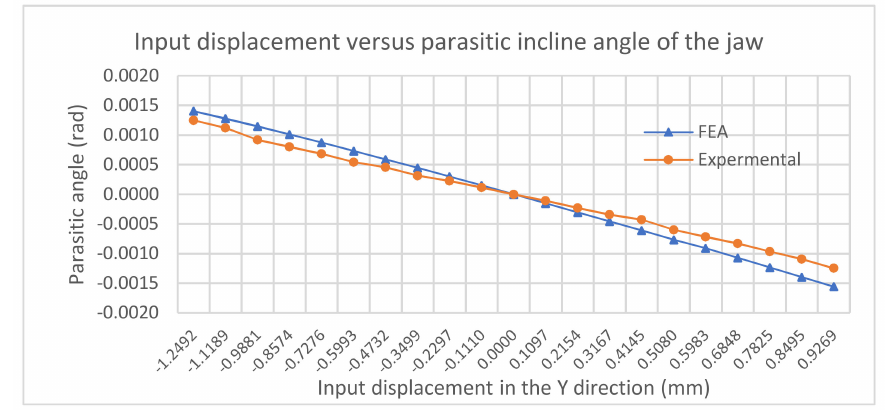
Figure 13. Parasitic rotation in Ө direction.